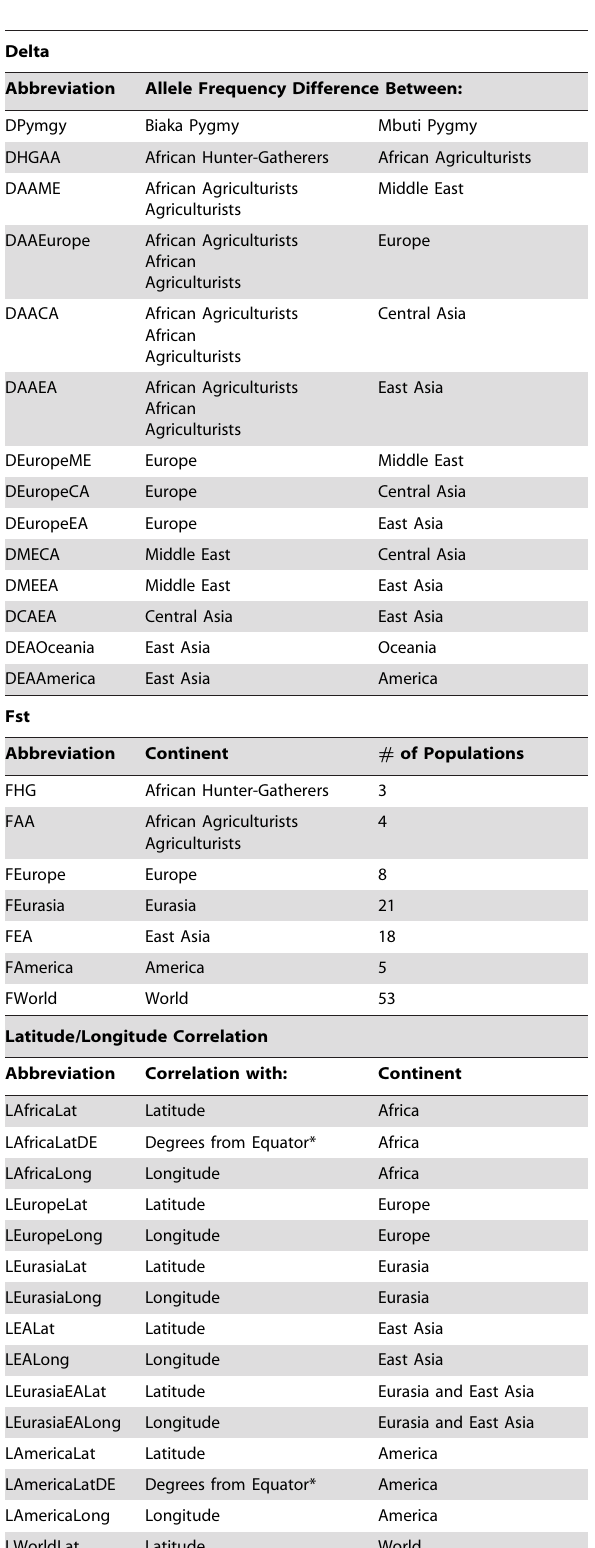
Table 1. List of all 45 Delta, F st , LLC, and iHS scores calculated for the CEPH-HGDP populations.